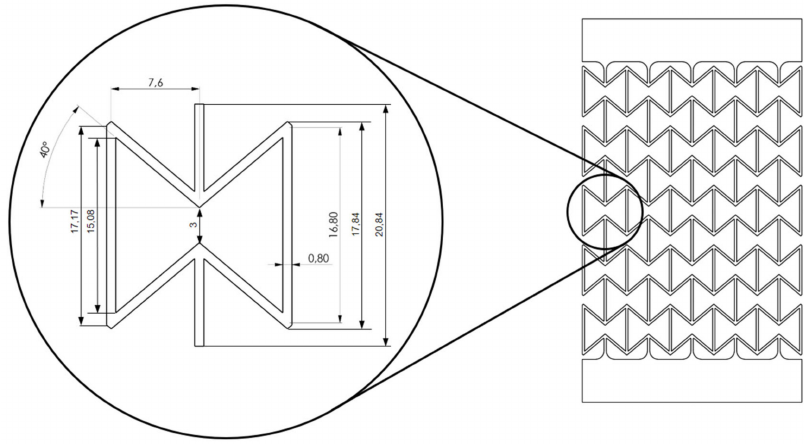
Figure 7. Schematic representation of a single honeycomb with its dimensions.